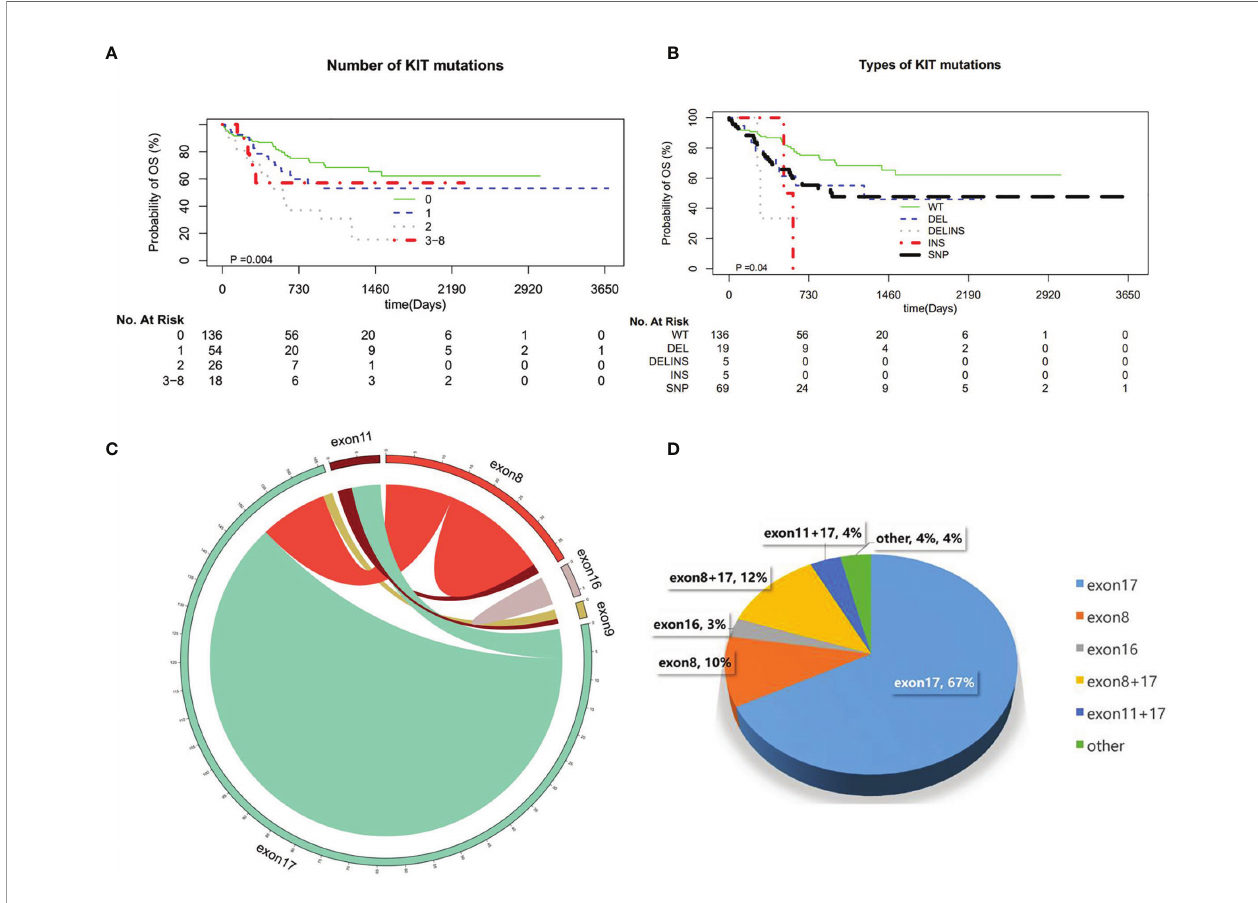
FIGURE 3 | (A) Number of KIT mutations. (B) Types of KIT mutations. (C) The distribution of KIT exons. (D) The scale of KIT